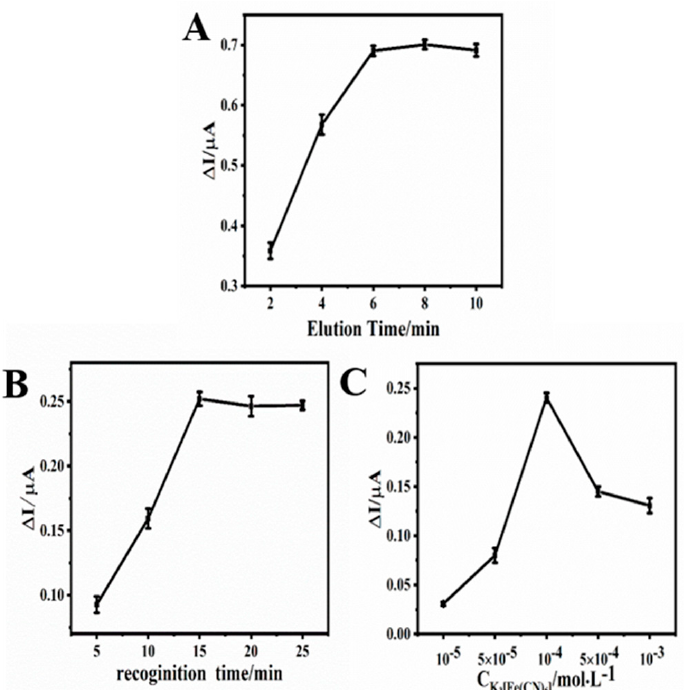
Figure 4. Optimization of ( A ) elution time; ( B ) recognition time; ( C ) concentration of K ₃ [Fe(CN) ₆ ]. The concentration of BPA is 10 nM.